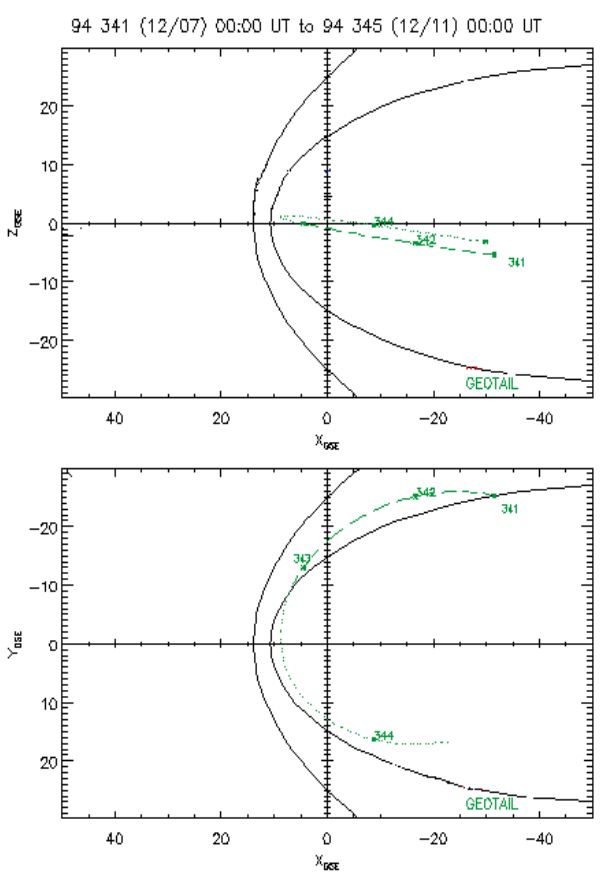
Figure 5 Fig. 5. Geotail orbit during the time interval 94, 341, 00:00 UT to 94, 345, 00:00 UT. During the time interval 341, 00:00 UT to 342, 12:00 UT the spacecraft moves in the dawn magnetosheath while it remains near the magnetopause and the low latitude boundary layer region of the